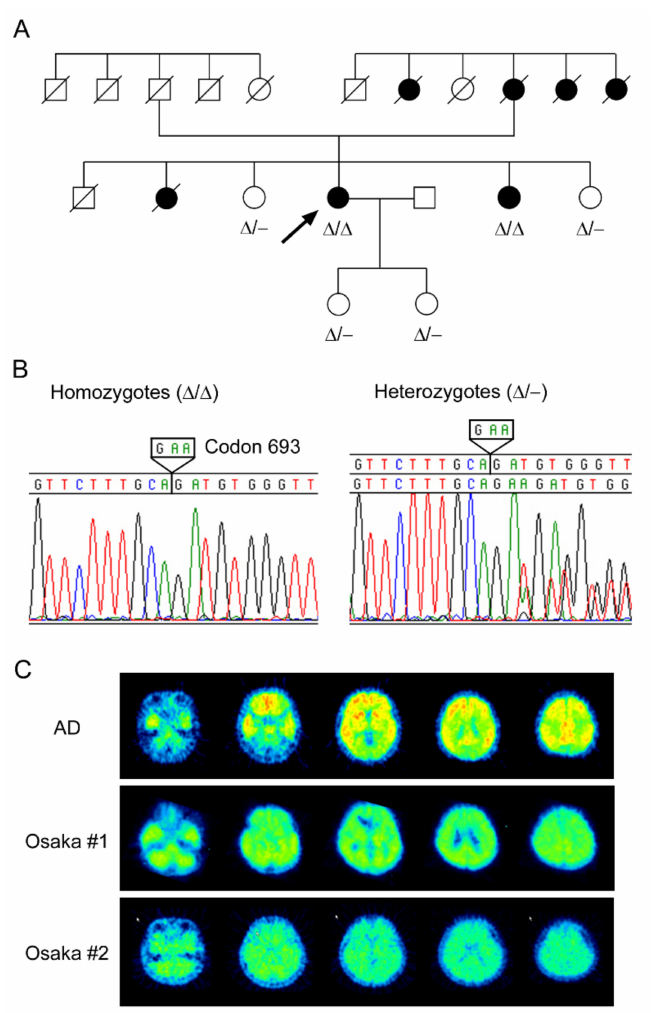
Figure 2. Recessive inheritance of the Osaka mutation. ( A ) Pedigree of familial Alzheimer’s disease (AD) with the Osaka mutation. The proband is indicated with an arrow. Both of the a ff ected members were homozygous ( ∆ / ∆ ) for the mutation, while una ff ected family members were all heterozygous ( ∆ / -). Square, male; circle, female. ( B ) DNA sequence of the Osaka mutation. Homozygous and heterozygous deletion of codon 693 of APP gene were detected in the pedigree. ( C ) No amyloid plaques in the Osaka mutation. Pittsburgh compound-B (PIB-PET) images of AD (71-year-old woman), the proband (62-year-old woman), and her a ff ected sister (61-year-old woman) are